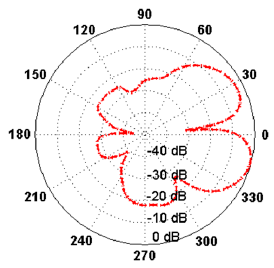
Figure 14. Simulated radiation pattern of Vivaldi antenna array with two-way 120-degree SIW power divider as feed system at 27 GHz.